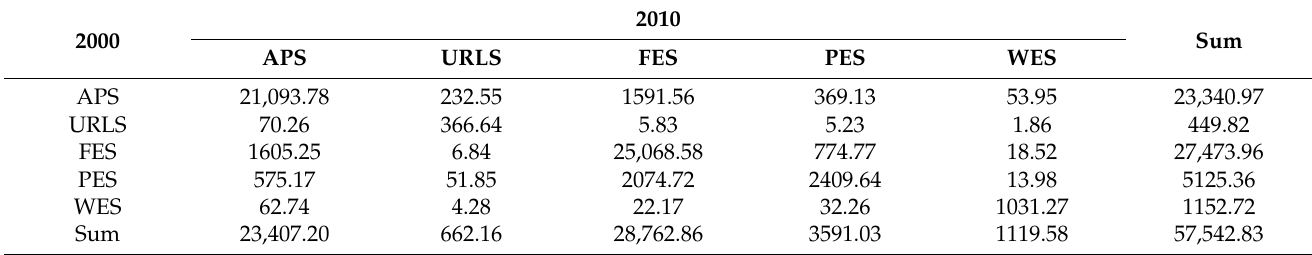
Table 3. Spatial transition matrix of the PLES in the TGRR from 2000 to 2010 (km 2 ).